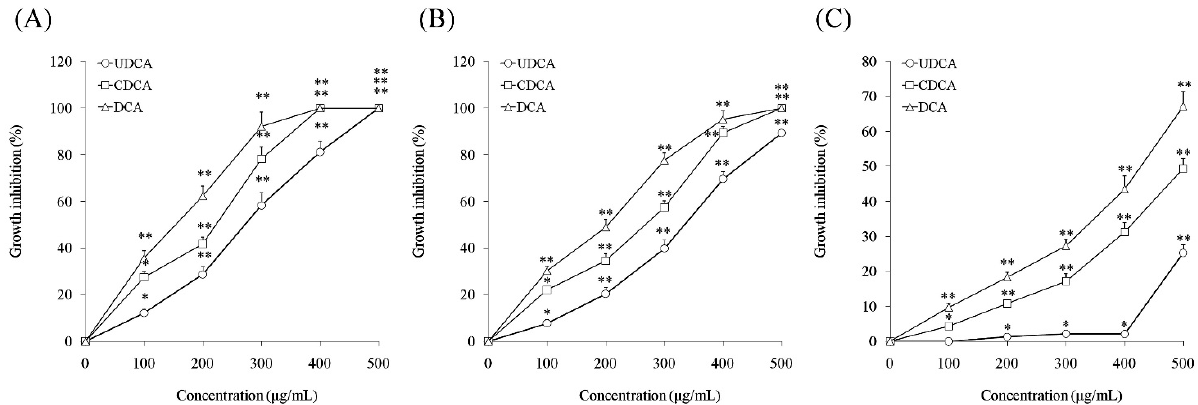
Figure 1. Growth inhibitory effects of ursodeoxycholic acid (UDCA), chenodeoxycholic acid (CDCA) and deoxycholic acid (DCA) in human oral squamous carcinoma HSC-3 cells ( A ), TCA8113 human tongue carcinoma cells ( B ), and HOK normal oral epithelial cells ( C ). * Mean values are significantly different from 0 μg/mL sample treatment ( p < 0.05)